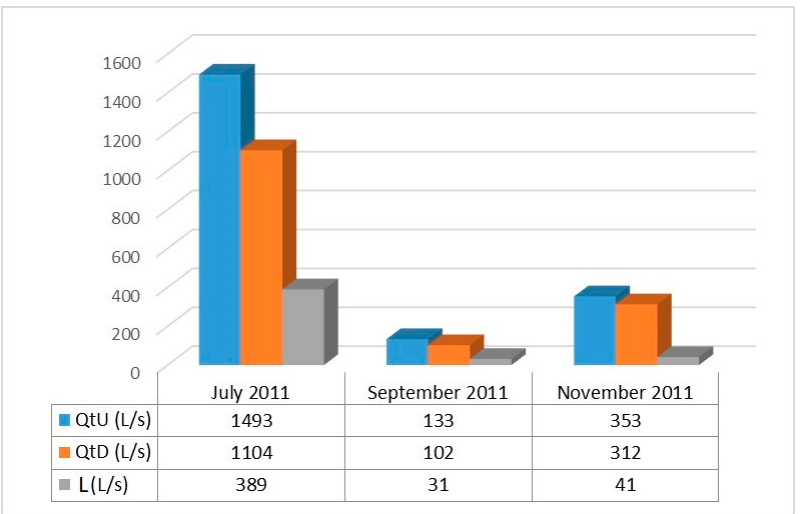
Figure 12. Comparison of the Renanchio Stream discharge in the upstream section (QtU) and downstream section (QtD) and losses (L) between the upstream section and the downstream section, in the three surveys (Test 1 in July 2011, Test 2 in September 2011, and Test 3 in November 2011).